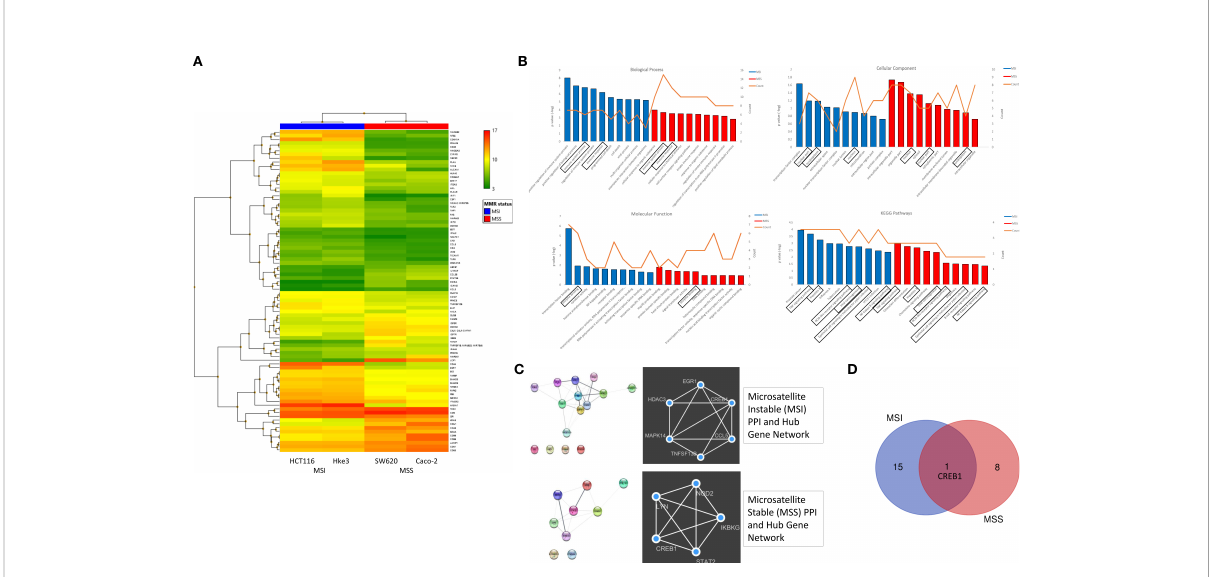
FIGURE 2 Differential expression of global immune response genes under reovirus infection in CRC cell lines categorized on MMR status. (A) Hierarchical- clustering pro fi le across differentially expressed genes (DEGs) participating in immune pathways upon treatment with reovirus in MSI and MSS groups. RMA normalized expression values for the 86 genes were used to generate a heat-map in the TAC software. The colors indicate the expression value relative to the median expression value per gene in the dataset. Red indicates upregulation relative to median value and green indicates downregulation relative to the median value. (B) GO term enrichment and KEGG pathway analyses of DEGs using DAVID. Differentially expressed probes between MSI and MSS cell lines treated with reovirus were selected based on meeting the criteria of p ≤ 0.05 and divided into positive and negative fold changes lists and used to determine enrichment. (C) Protein interaction analysis using STRING. The different colored nodes represent different genes. Different edges (lines) show the interplay between genes. Edge strength is shown by thickness of the line, the thicker the line, the stronger the interaction. Hub networks made using MCODE demonstrate the genes within the PPI that were screened to display the most highly upregulated. The genes not included in the hub networks did not have substantial interaction amongst the other genes in the list, therefore they were not included. (D) Venn diagram created using the TAC software. It illustrates the clear point that between the MMR subgroups, CREB1 gene is the only commonality out of 25 genes, 16 in the MSI and 9 genes in the MSS